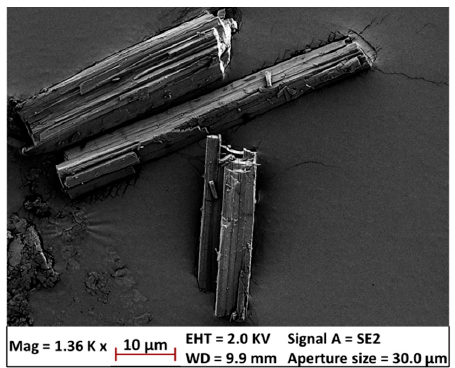
Figure 1. Oblong crystallites of Co(H 2 O) 2 PO 3 C–C 12 H 9 · H 2 O observed by scanning electron microscopy.